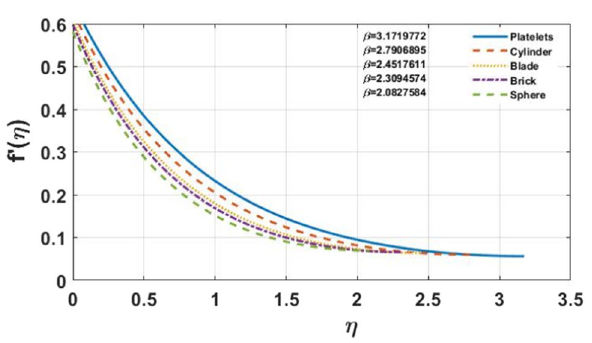
0.02, S 0.4, K 0.5, M = = = =